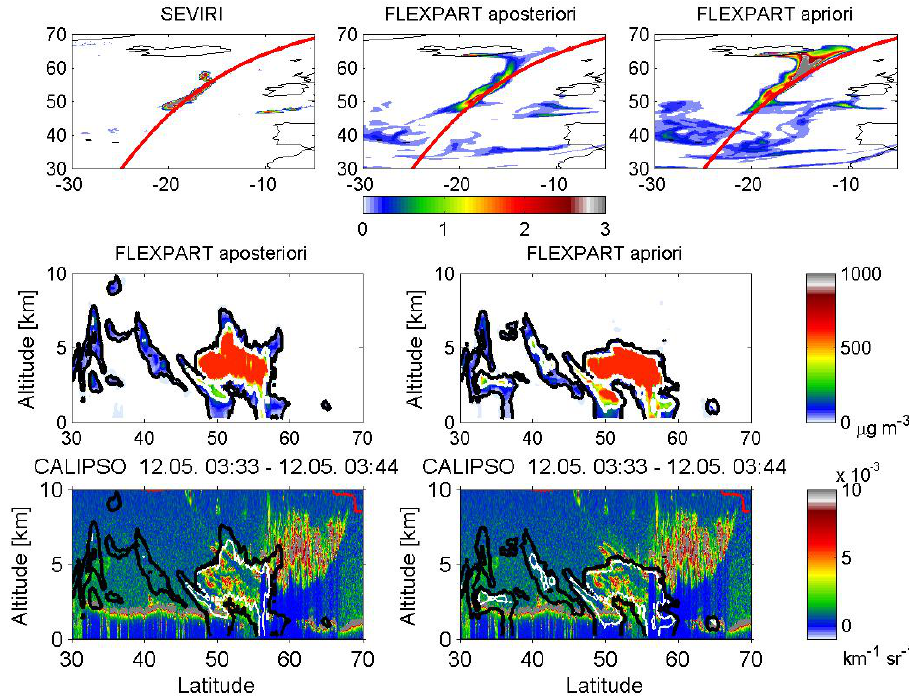
Fig. A4. Same as Fig. A1, but for 12 May at 4 UTC.